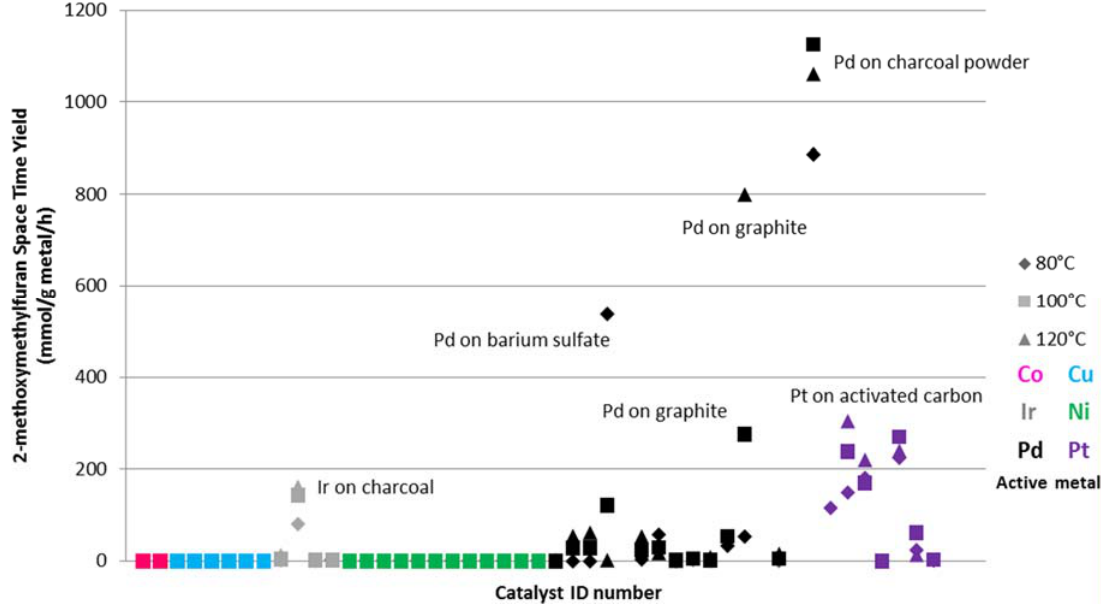
Figure 1. 2-metoxymethyl furan (FME) Space Time Yield (mmol/g supported metal/h) vs. catalyst ID number (see Table 1). Different color marks were used in the figure for the six active metal catalysts: pink (cobalt), grey (iridium), black (palladium), light blue (copper), green (nickel), violet